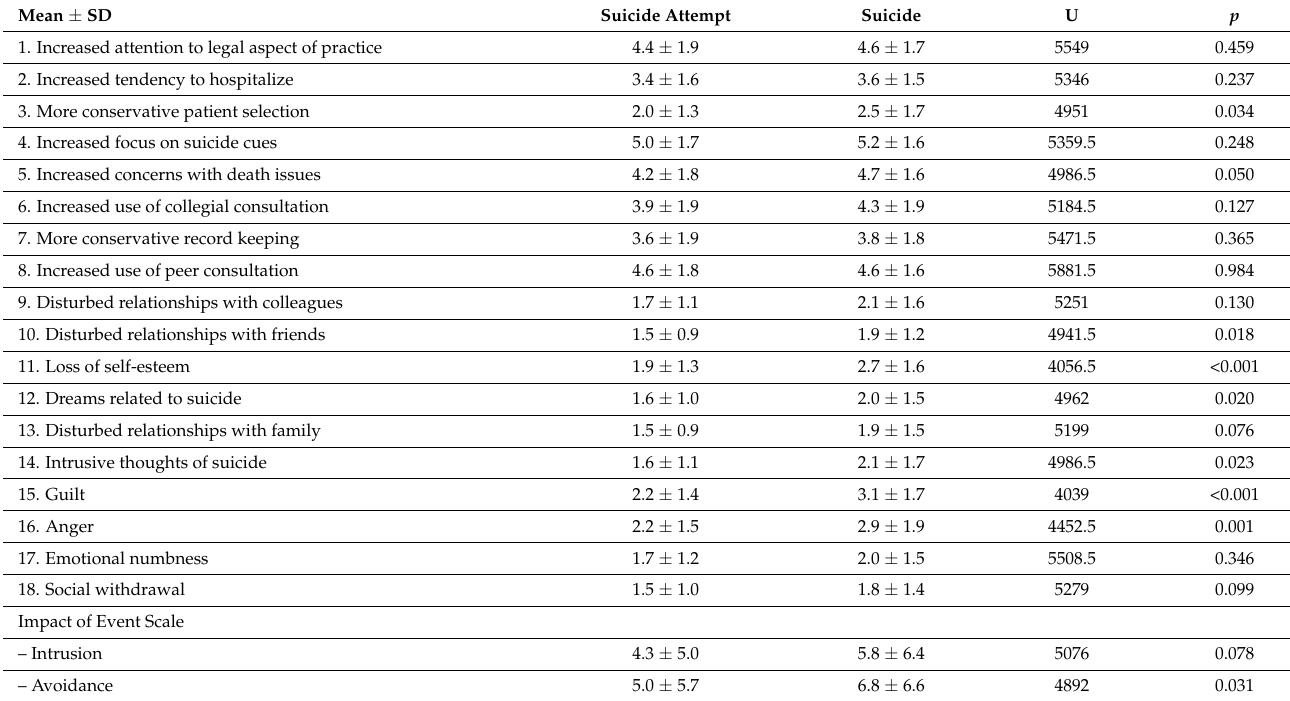
Table 5. Differences between experience of patient’s suicide attempt versus